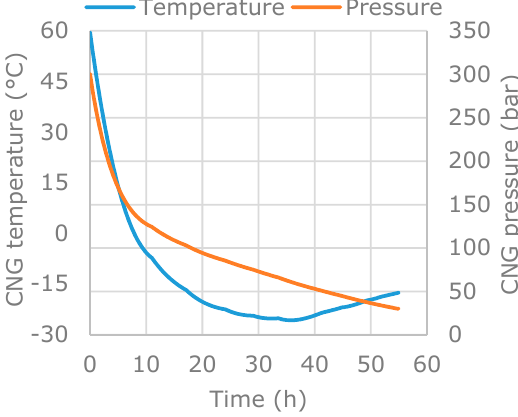
Figure 19. Pressure vessels CNG conditions (winter unloading).